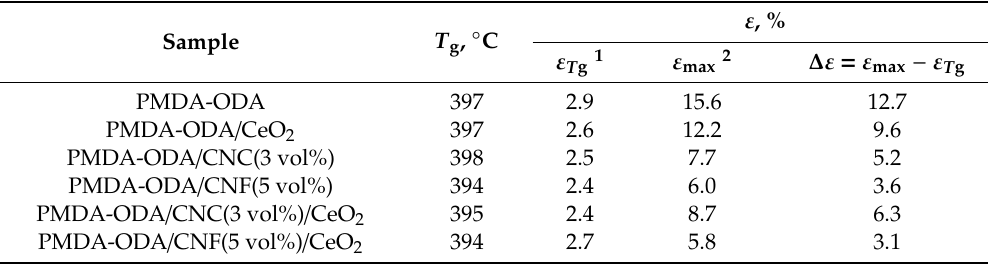
Table 2. Thermomechanical characteristics of PMDA-ODA (PI with a repeating unit based